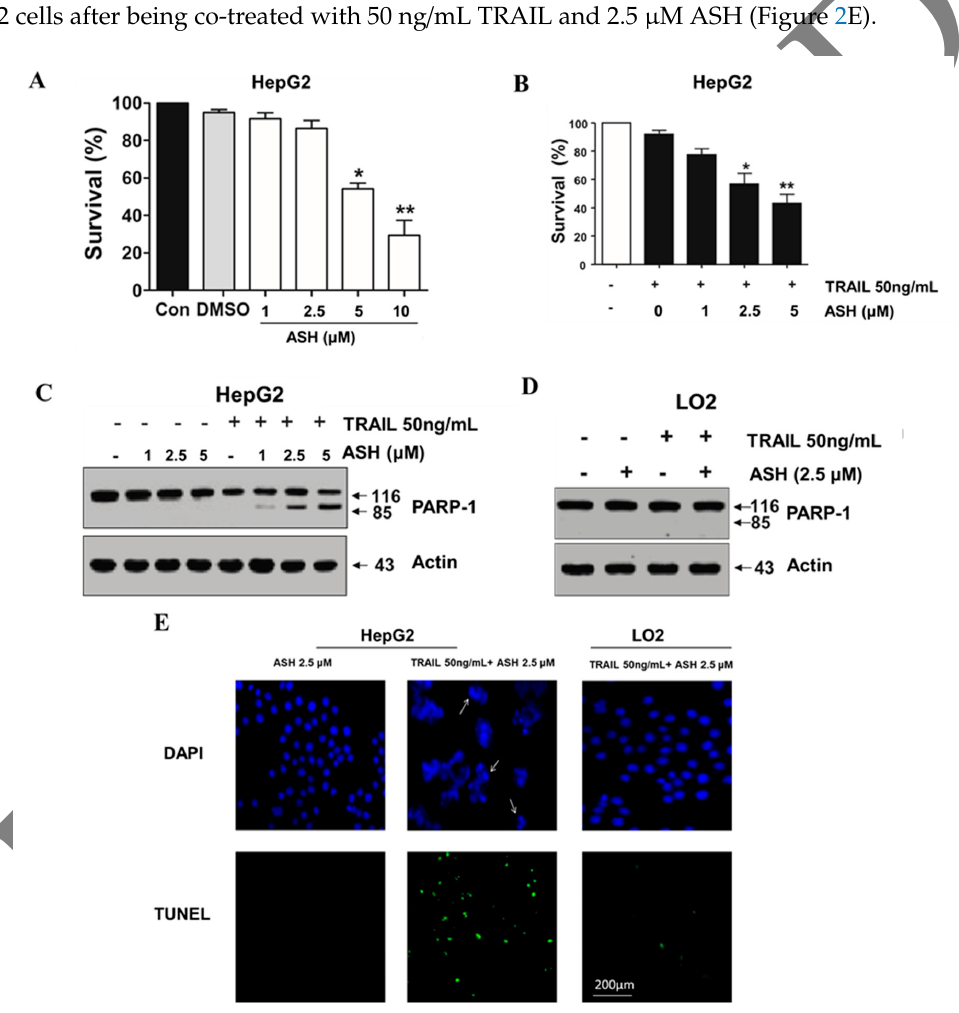
Figure 2. Non-apoptosis-inducing doses of acetylshikonin (ASH) reversed the resistance